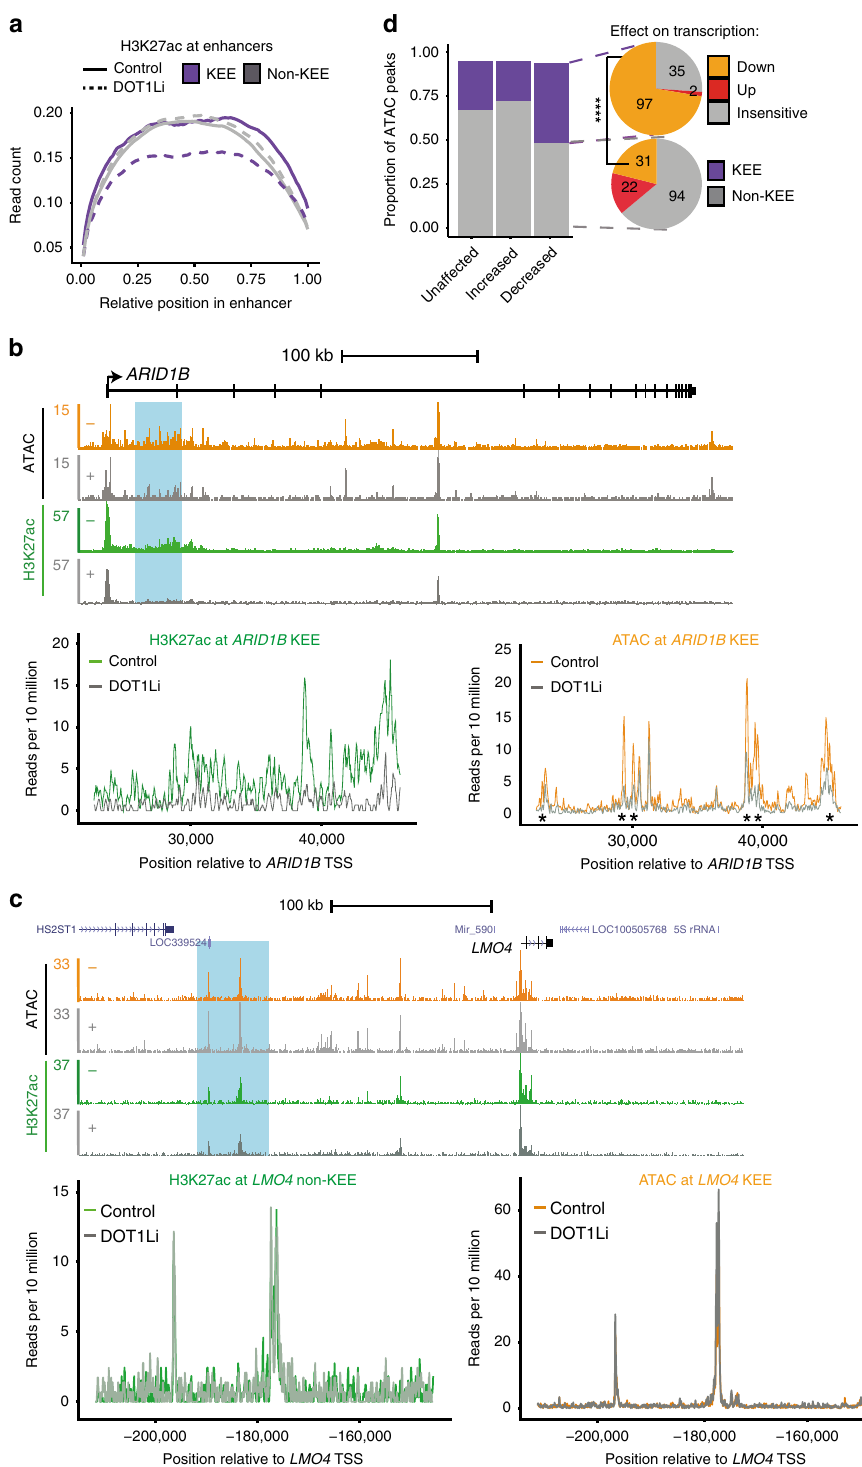
Fig. 3 Loss of H3 lysine 79 methylation 2/3 (H3K79me2/3) leads to reduction in H3 lysine 27 acetylation (H3K27ac) and chromatin accessibility at H3K79me2/3 Enhancer Elements (KEEs). a Metaplot of H3K27ac chromatin immunoprecipitation-sequencing (ChIP-seq) signal across KEEs (purple) or non-KEEs (gray) in control (solid line) and DOT1Li (dashed line) SEM cells, n = 1. b , c Upper: assay for transposase-accessible chromatin using sequencing (ATAC-seq) and H3K27ac ChIP-seq at ARID1B and LMO4 in control ( − , orange/green) and DOT1Li ( + , gray) SEM cells. Blue boxes highlight KEE cluster 1 region of ARID1B and non-KEE region associated with LMO4 . Lower: Overlay of H3K27ac (left) and ATAC (right) signal at ARID1B KEE1 and LMO4 non-KEE in control (green/orange) and DOT1Li (gray). Asterisks represent signi fi cant decreases in ATAC signal following DOT1Li, false discovery rate (FDR) < 0.05. d Left: Proportion of increased, decreased, or unchanged ATAC peaks found within a KEE (purple) or non-KEE (gray). Right: Proportion of decreased ATAC peaks within a KEE (upper) or non-KEE (lower) that are associated with transcriptionally downregulated (orange), upregulated (red), or insensitive (gray) gene. **** P < 0.0001, Fisher ’ s exact test, n = 5. See also Supplementary Fig.